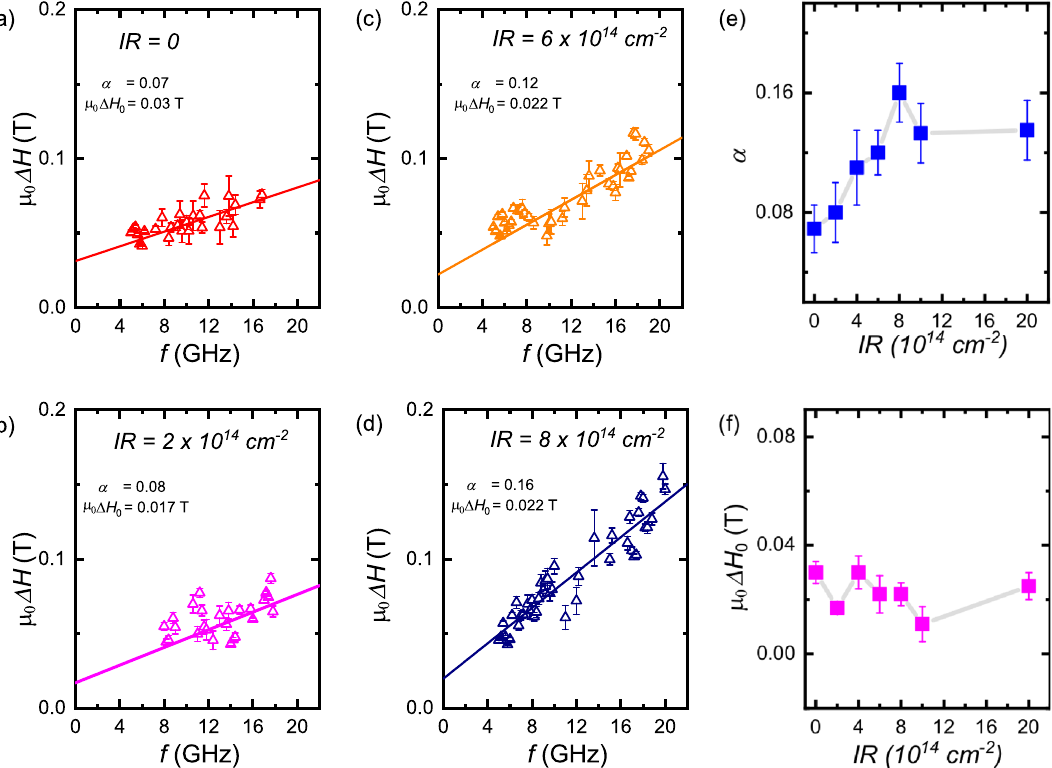
Figure 4. ( a – d ) Dependence of the linewidth, µ 0 � H , on the microwave frequency, f , with in the out-of-plane external magnetic field µ 0 H for different IR. The solid lines are linear fits. ( e ) Plot of damping constant α and ( f ) Inhomogeneous broadening component µ 0 � H 0 for different